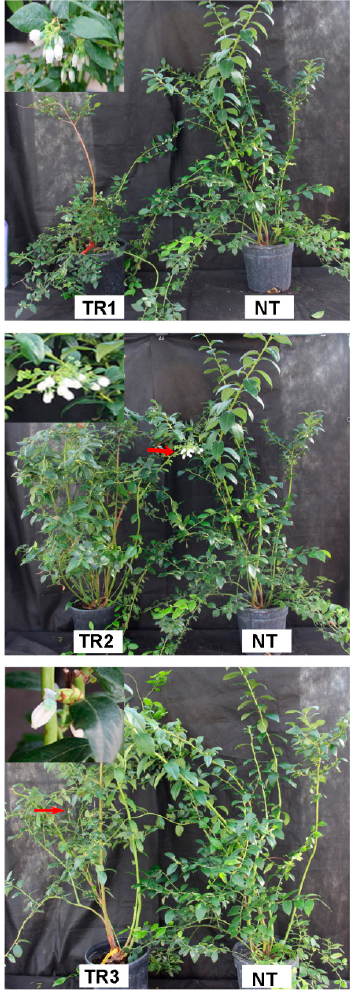
Figure 5. Early flowering of the transgenic blueberry plants carrying 35S -MdFLC under nonchilling conditions where nontransgenic (NT) plants could not flower. ( a–c ) Early flowering of nonchilled plants of three transgenic events (TR1, TR2, and TR3) in the third year after being transferred to soil. ( d ) NT plant (right) that could not flower despite the appearance of flower buds.